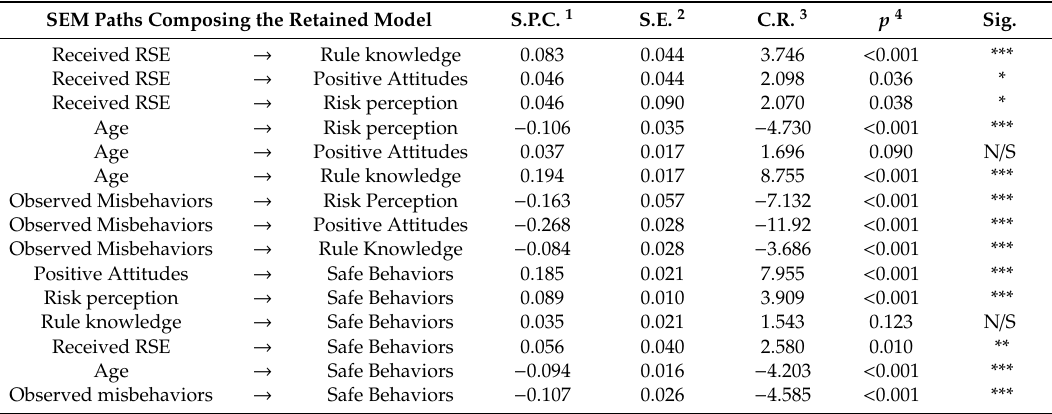
Table 3. Structural Equation Model (SEM) for predicting safe (protective) behaviors.